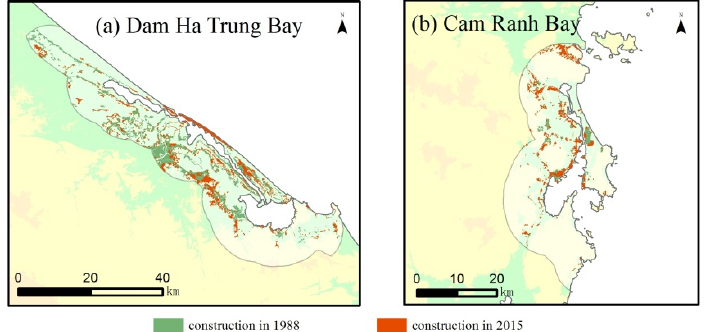
Figure 13. Spatial distribution of construction land in Dam Ha Trung Bay and Cam Ranh Bay. ( a ) Dam Ha Trung Bay; ( b ) Cam Ranh Bay.